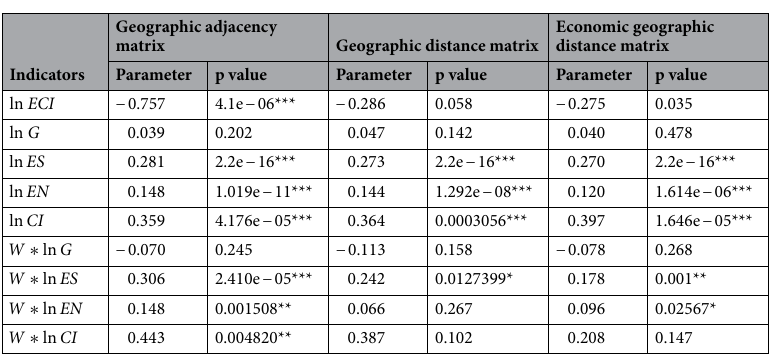
Table 6. The SDM model estimation results. *, **and*** mean significant at the confidence level of 10%, 5% and 1%, respectively.